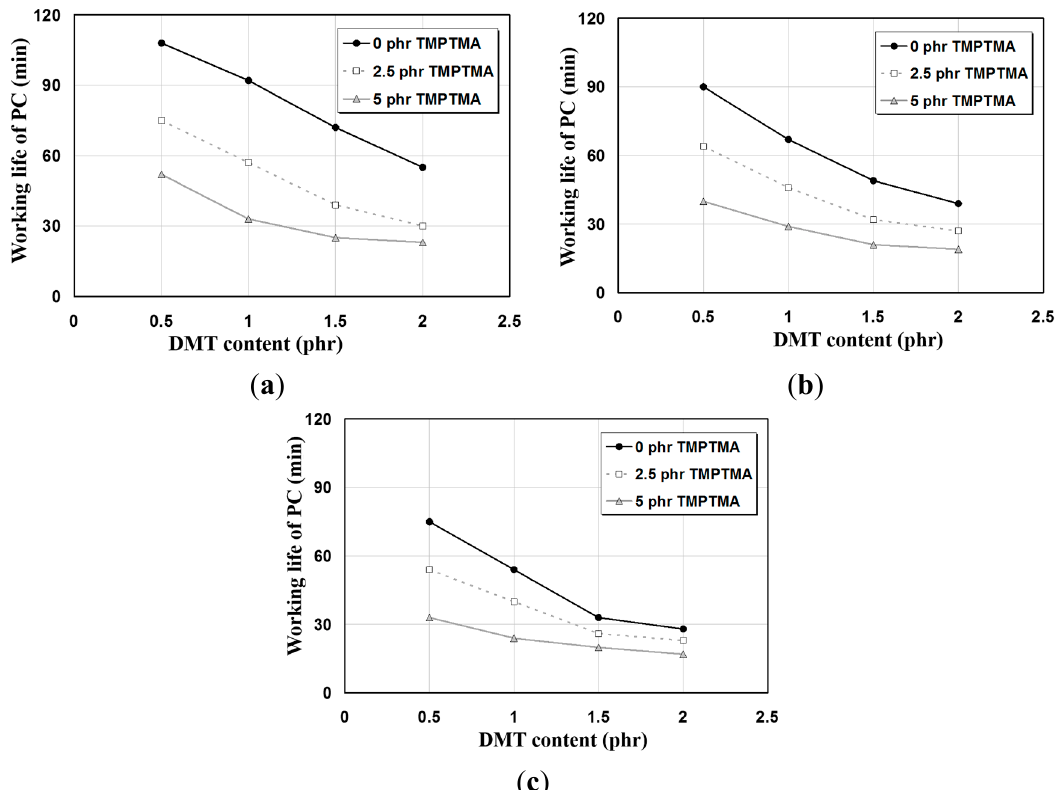
Figure 4. Effects of DMT and TMPTMA contents on the working life of acrylic polymer concrete cured at different temperatures. ( a ) − 20 °C; ( b ) − 10 °C; and ( c ) 0 °C.